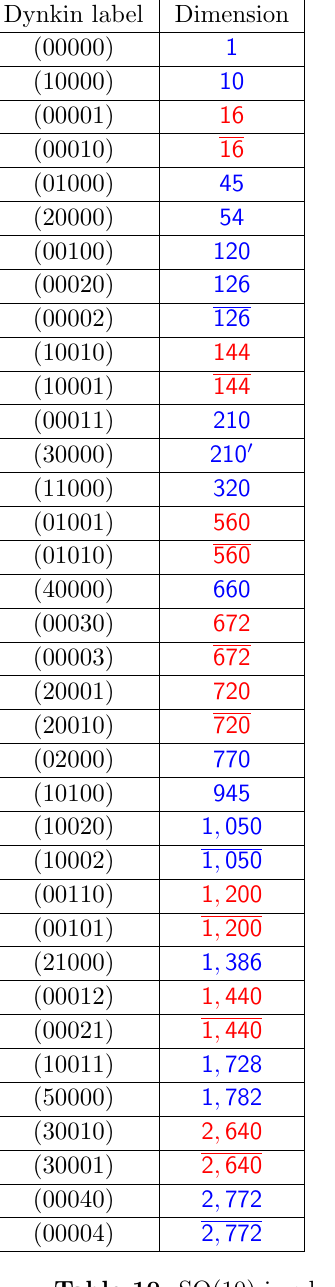
Table 10 . SO(10) irreducible representations